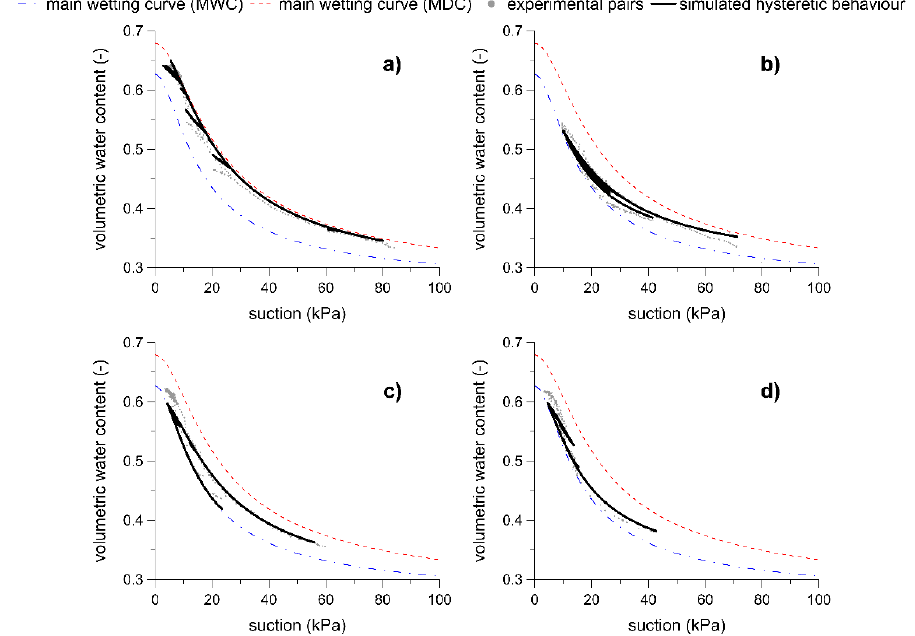
Figure 6. Observed (grey dots) and simulated (black line) matric suction – volumetric water content paths for the four hydrological years: 2010 – 2011 ( a ), 2011 – 2012 ( b ), 2012 – 2013 ( c ), and 2013 – 2014 ( d ). Main drying curve: red dashed line; main wetting curve: blue dot-line hatching.